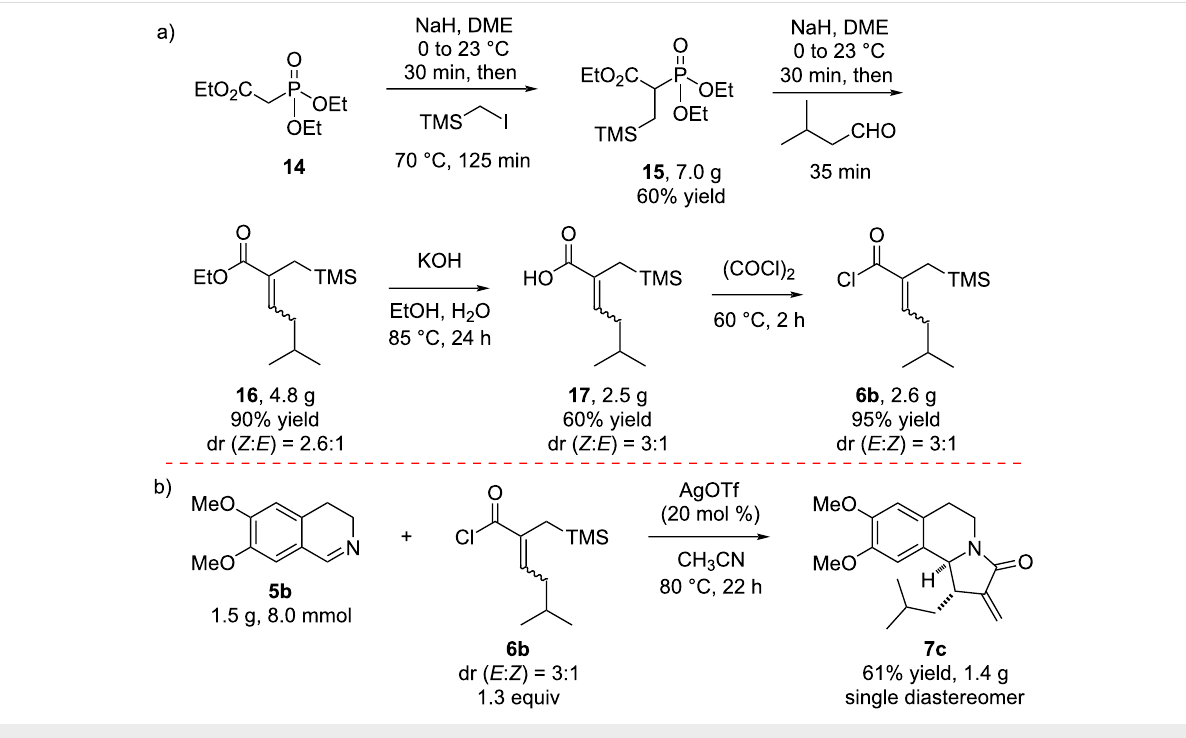
Scheme 2: Aza-Nazarov cyclization on gram